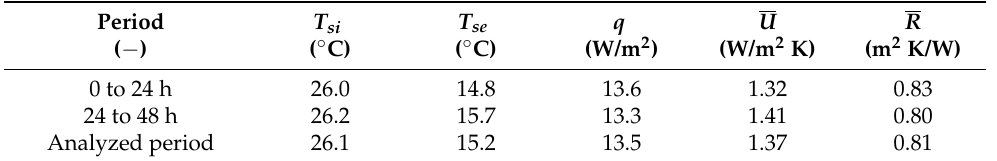
Table 6. Mean values of the thermal properties derived from the collected data over the analyzed time